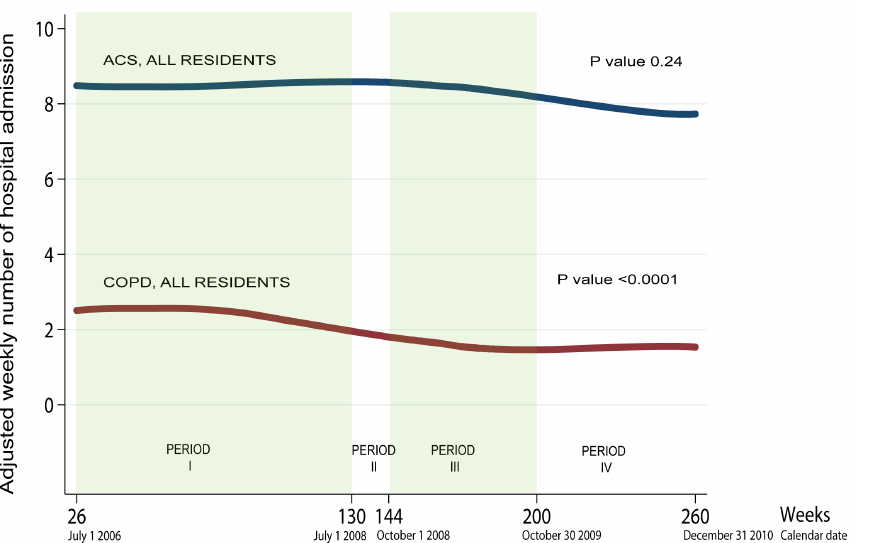
Figure 1. Adjusted weekly numbers of hospitalizations for acute COPD exacerbations and acute coronary syndromes (ACS). Footnote: Global P values for adjusted incidence rate ratio trend tests (reference=period 1, weeks 26 to 130), see Table 2. Curves displayed using smoothed values (Stata lowess function). doi:10.1371/journal.pone.0090417.g001 (Table 2). The number of hospitalisations for pneumonia and asthma was particularly low in each study period. For acute COPD exacerbation, the weekly number of hospitalisations significantly dropped over the 4 periods from